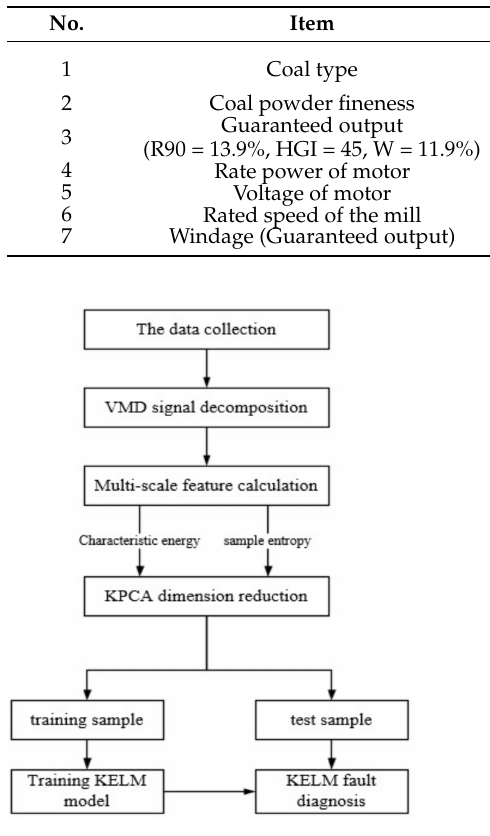
Figure 2. VMD-FE+SE-KPCA-KELM modeling flow